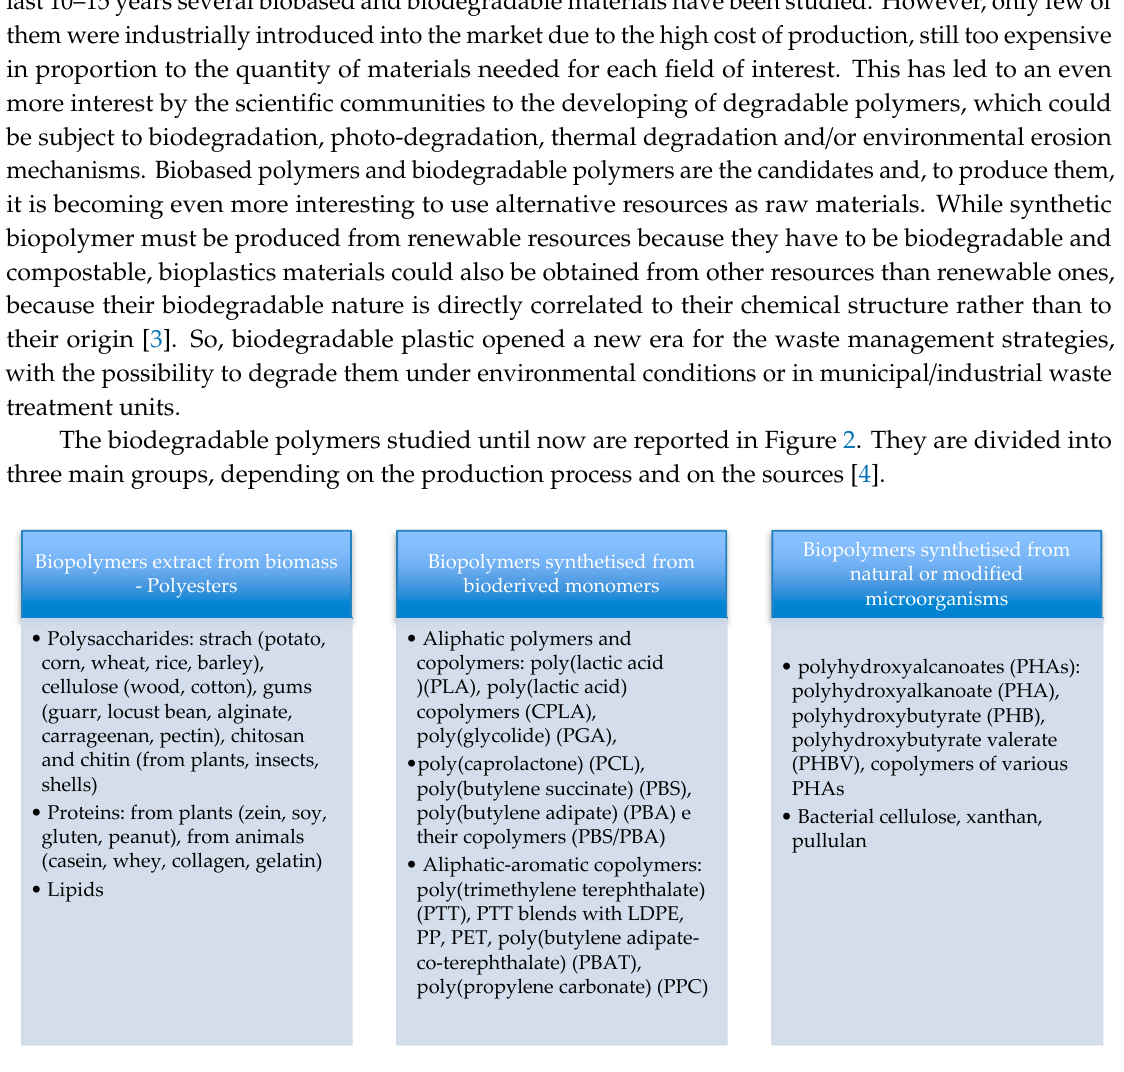
Figure 2. Biobased packaging materials.